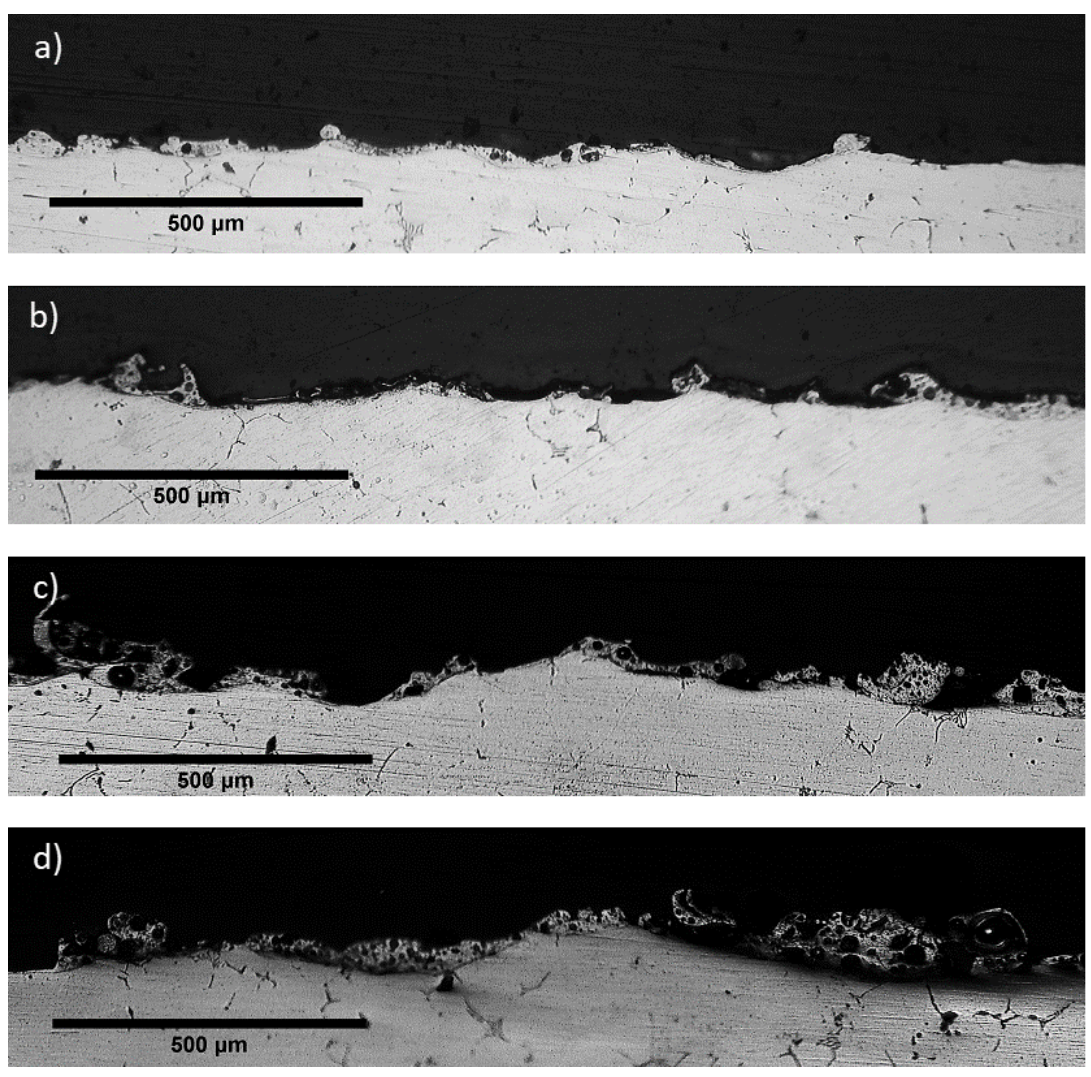
Figure 4. WL for I P = 18 A and T on ( a ) 100 μs. ( b ) 200 μs. ( c ) 300 μs. ( d ) 500 μs.